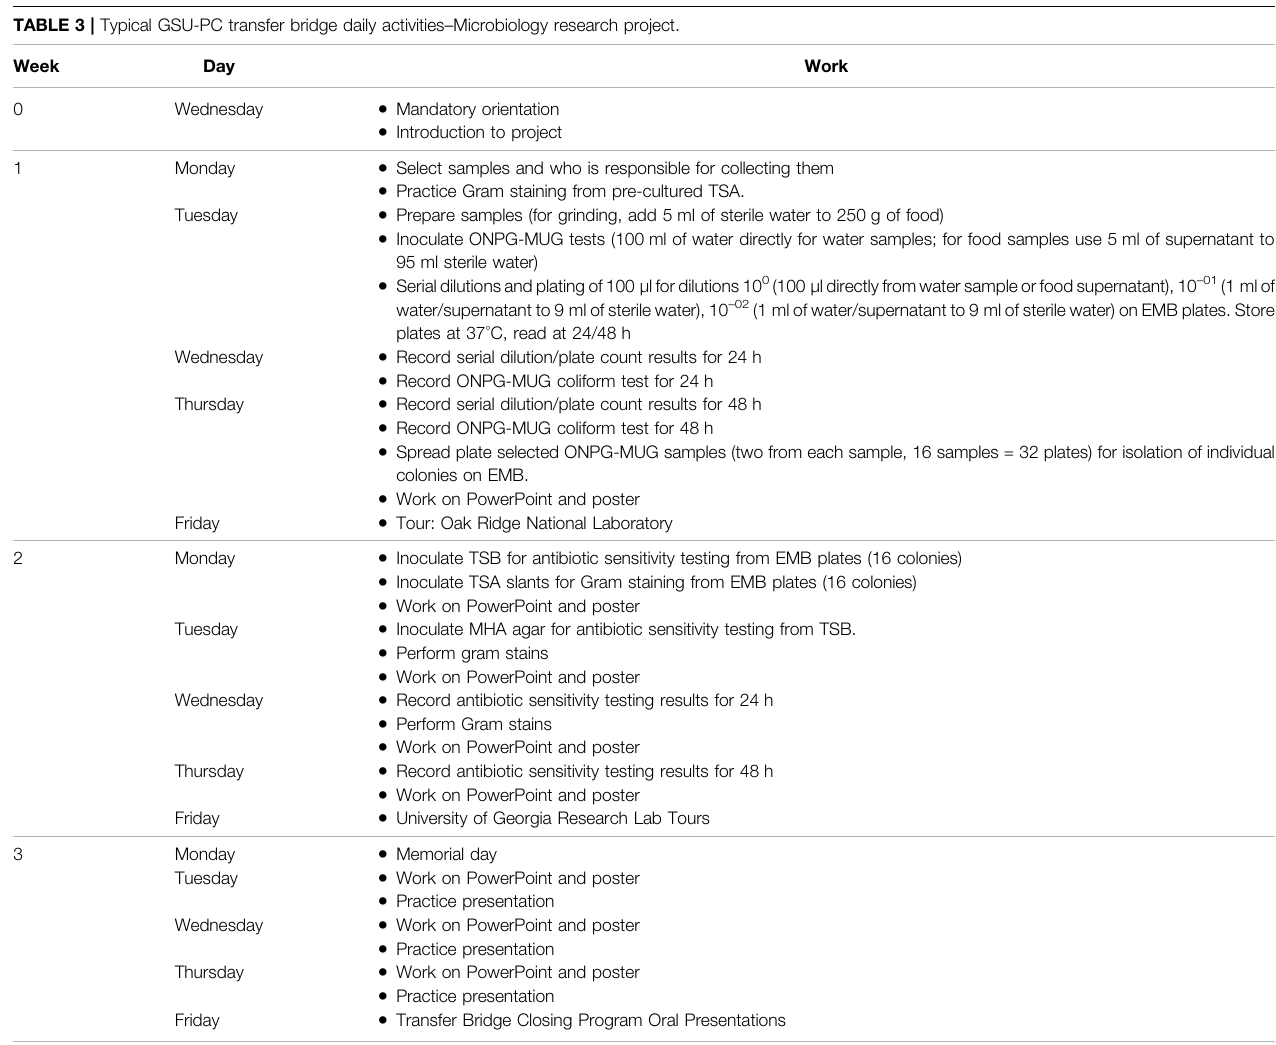
TABLE 3 | Typical GSU-PC transfer bridge daily activities – Microbiology research